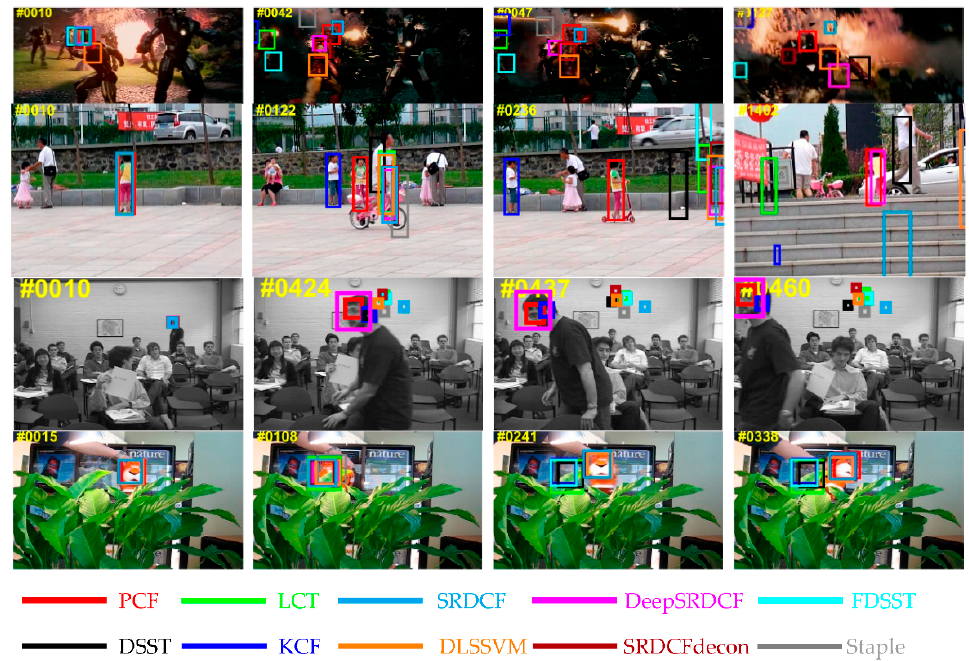
Figure 9. The qualitative experiments from four representative sequences on the OTB-2013 benchmark. The results for the top ten trackers are expressed in different colors. On these challenging sequences, the proposed PCF tracker achieves remarkable results compared to the other top nine trackers in terms of accuracy and robustness. 4.4. Experiments on OTB-2015